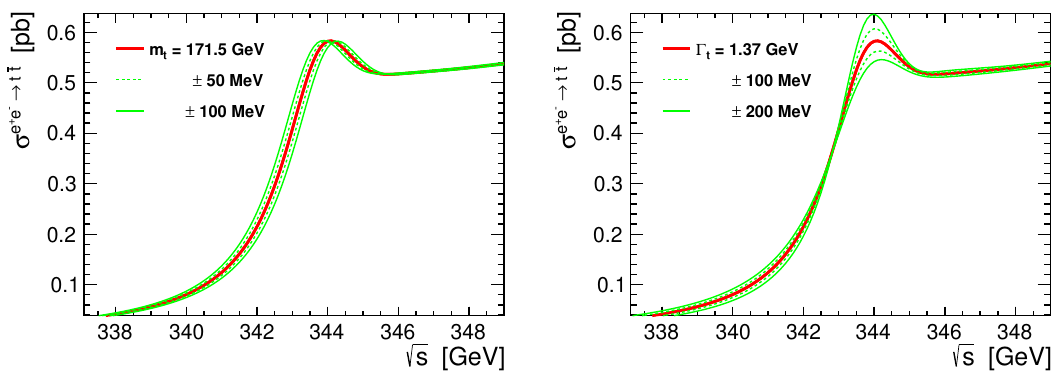
Figure 2 . Examples of cross-section templates generated using QQbar_threshold software for different values of top-quark mass (left) and width (right)